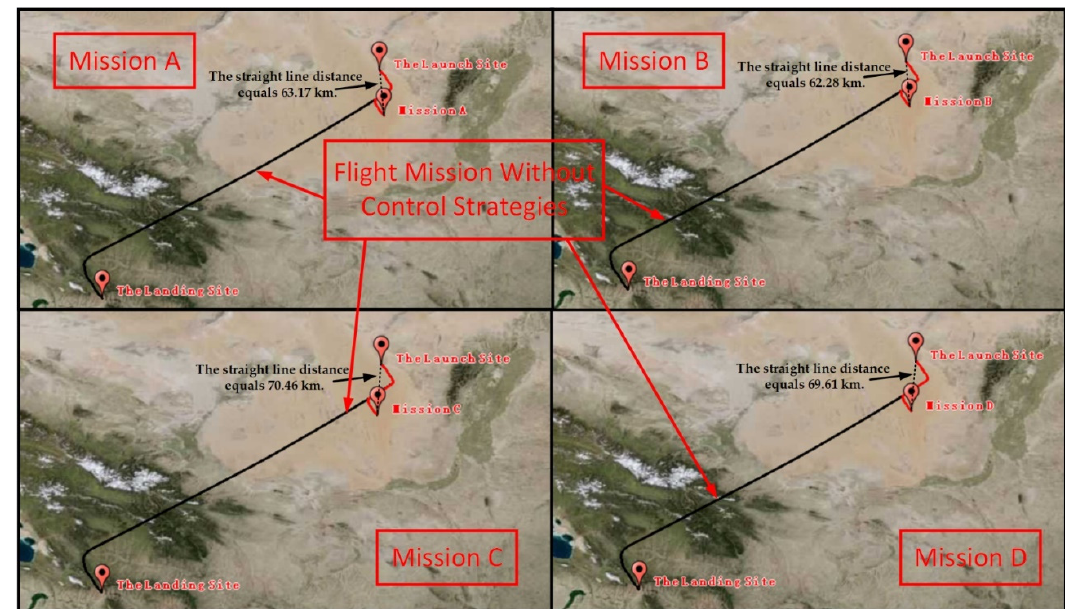
Figure 19. Simulation results of Mission D: balloon system’s change in vertical speed vs. time and change in altitude vs. time while the control strategies are applied (or not).